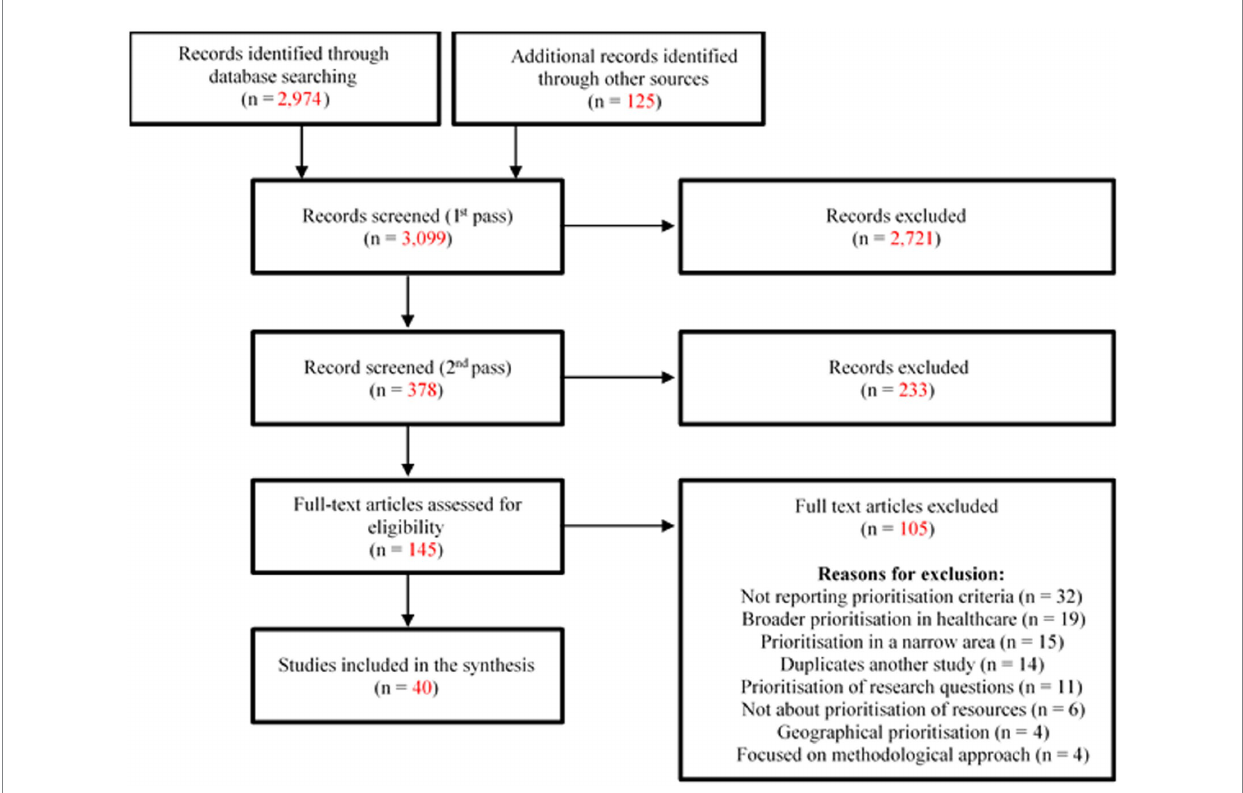
FIGURE 1 PRISMA flow diagram summarising the search and selection process in this scoping